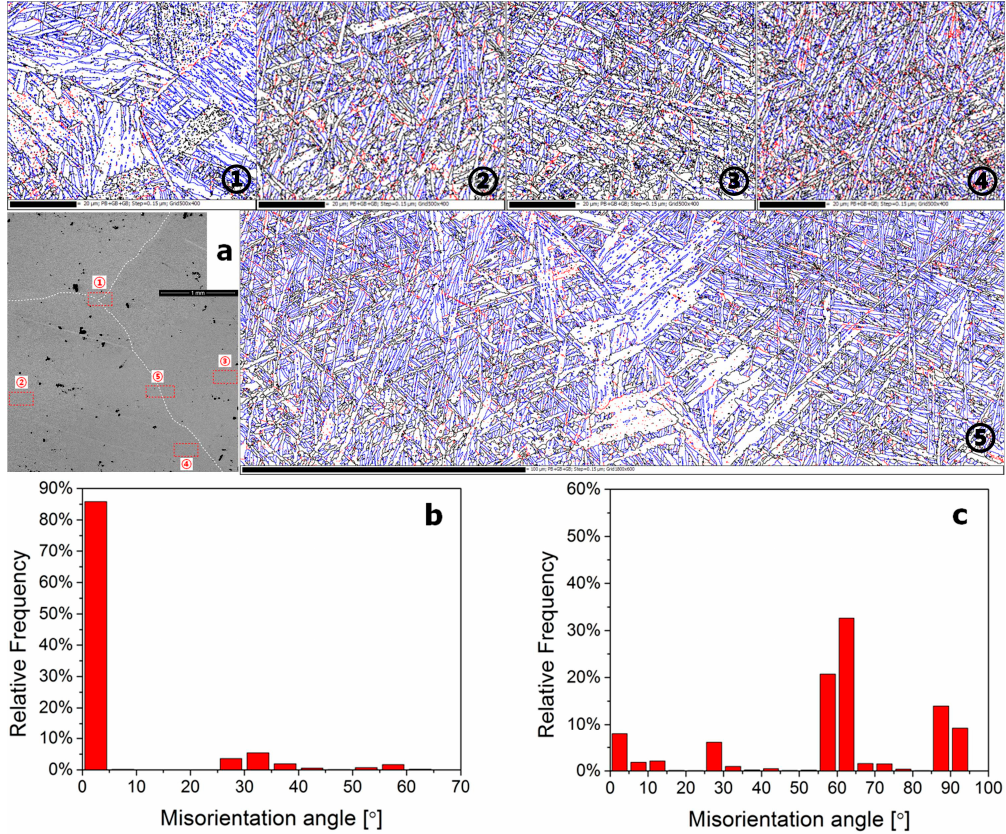
Figure 7. Electron backscatter diffraction (EBSD) grain boundary map ( a ) and corresponding misorientation distributions of the as-cast β 20C alloy in β ( b ) and α ( c ) phases.